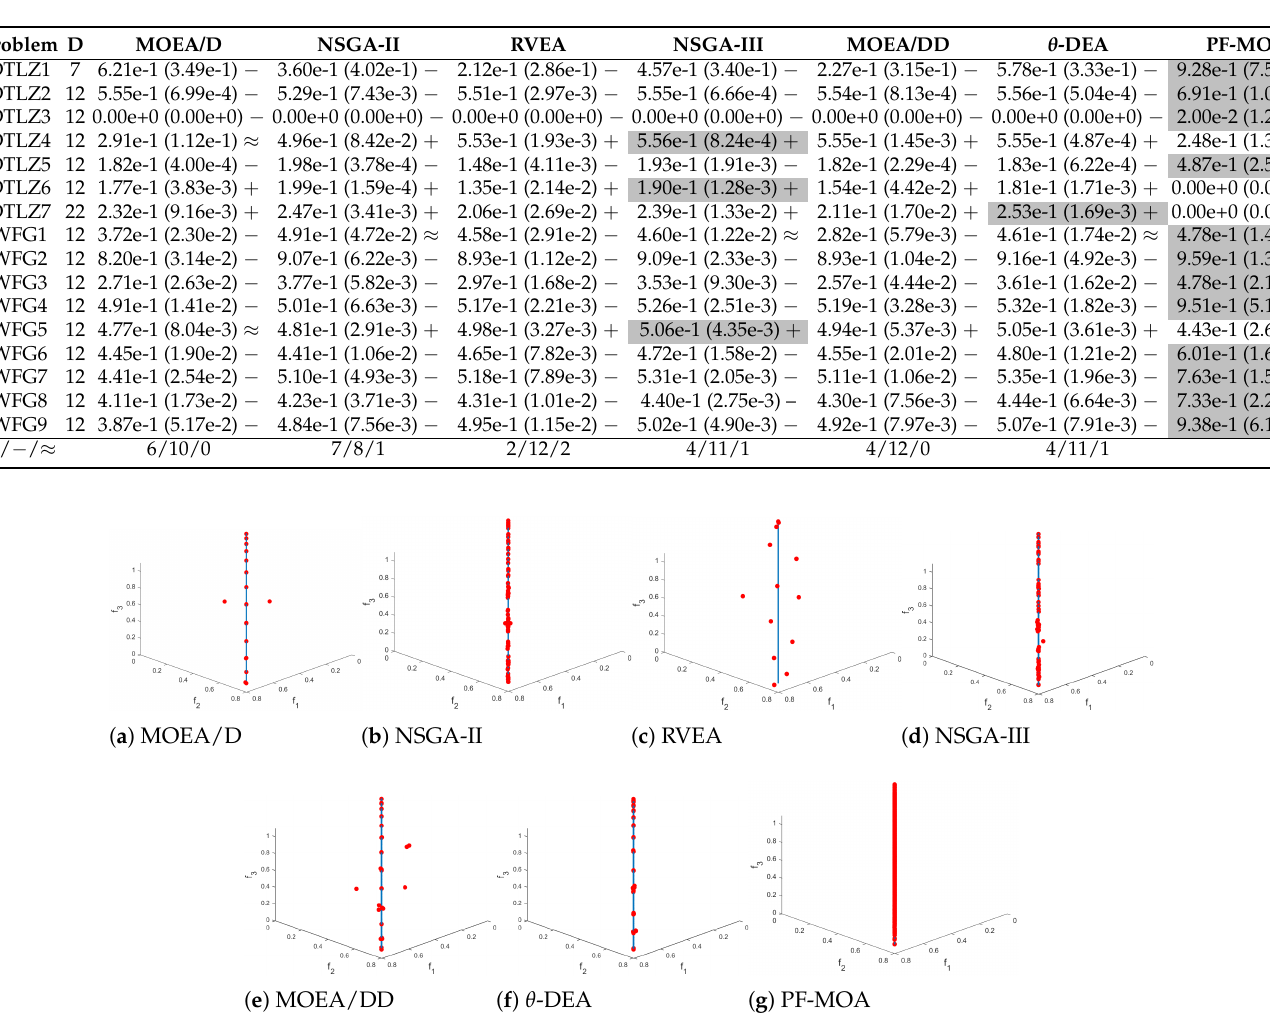
Table 2. Statistical results of the HV values obtained by NSGA-II, RVEA, MOEA/D, MOEA/DD, NSGA-III, θ -DEA and PF-MOA with the same number of real function evaluations.